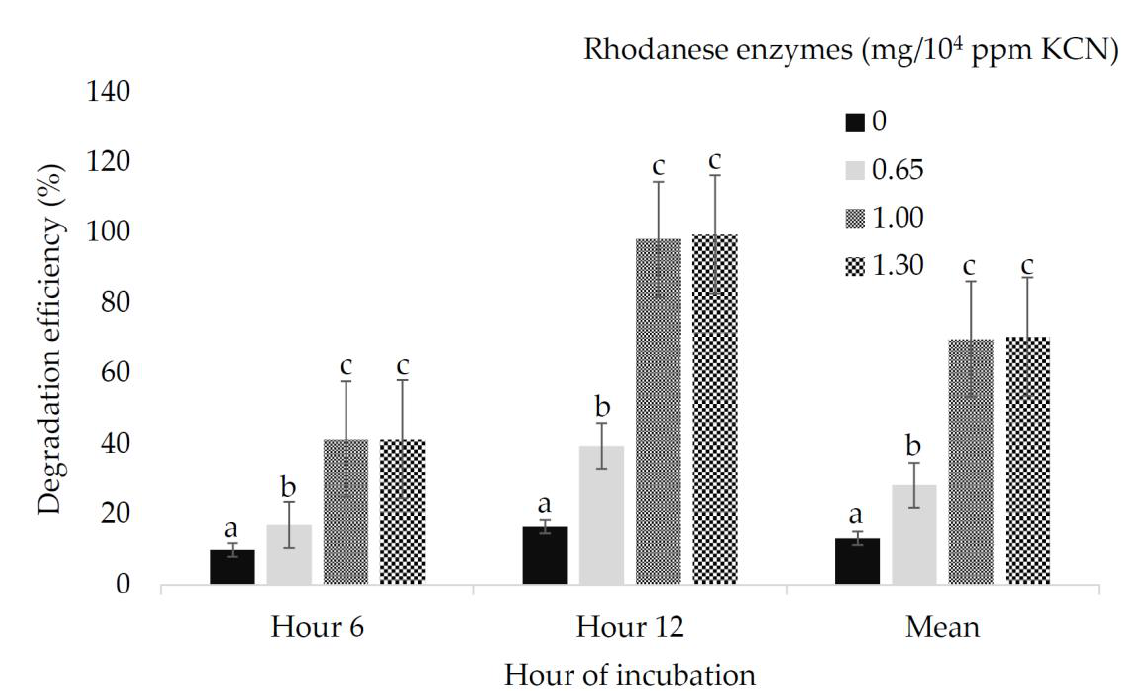
Figure 2. Effect of rhodanese enzyme levels on ruminal degradation efficiency of cyanide (%) at various hours of incubation [a–c Means in the same hour with different superscripts differ ( p < 0.05)]. Table 3. Addition of rhodanese enzymes and potassium cyanide (KCN) levels on pH, ammonia-nitrogen (NH 3 -N) and in vitro